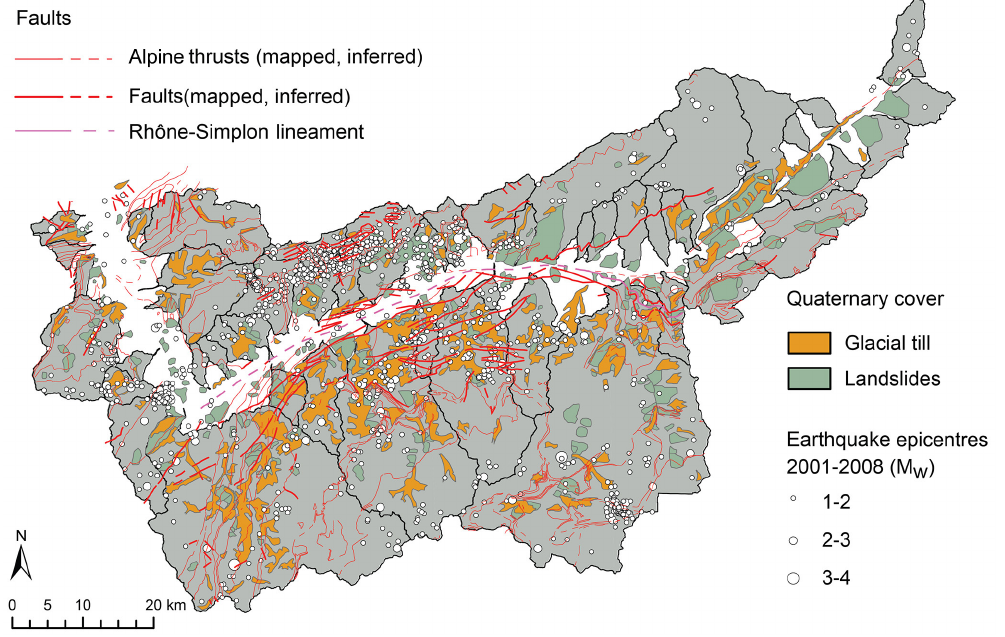
Figure 15. Compiled map of faults (geological map of Switzerland 1:25000), earthquake epicentres (Swiss Earthquake Catalogue) and landslides (Tonini et al., 2014). For reasons of clarity, we display only the earthquake epicentres of a short time period. For the full data set and more detail about the data, see Fäh et al.